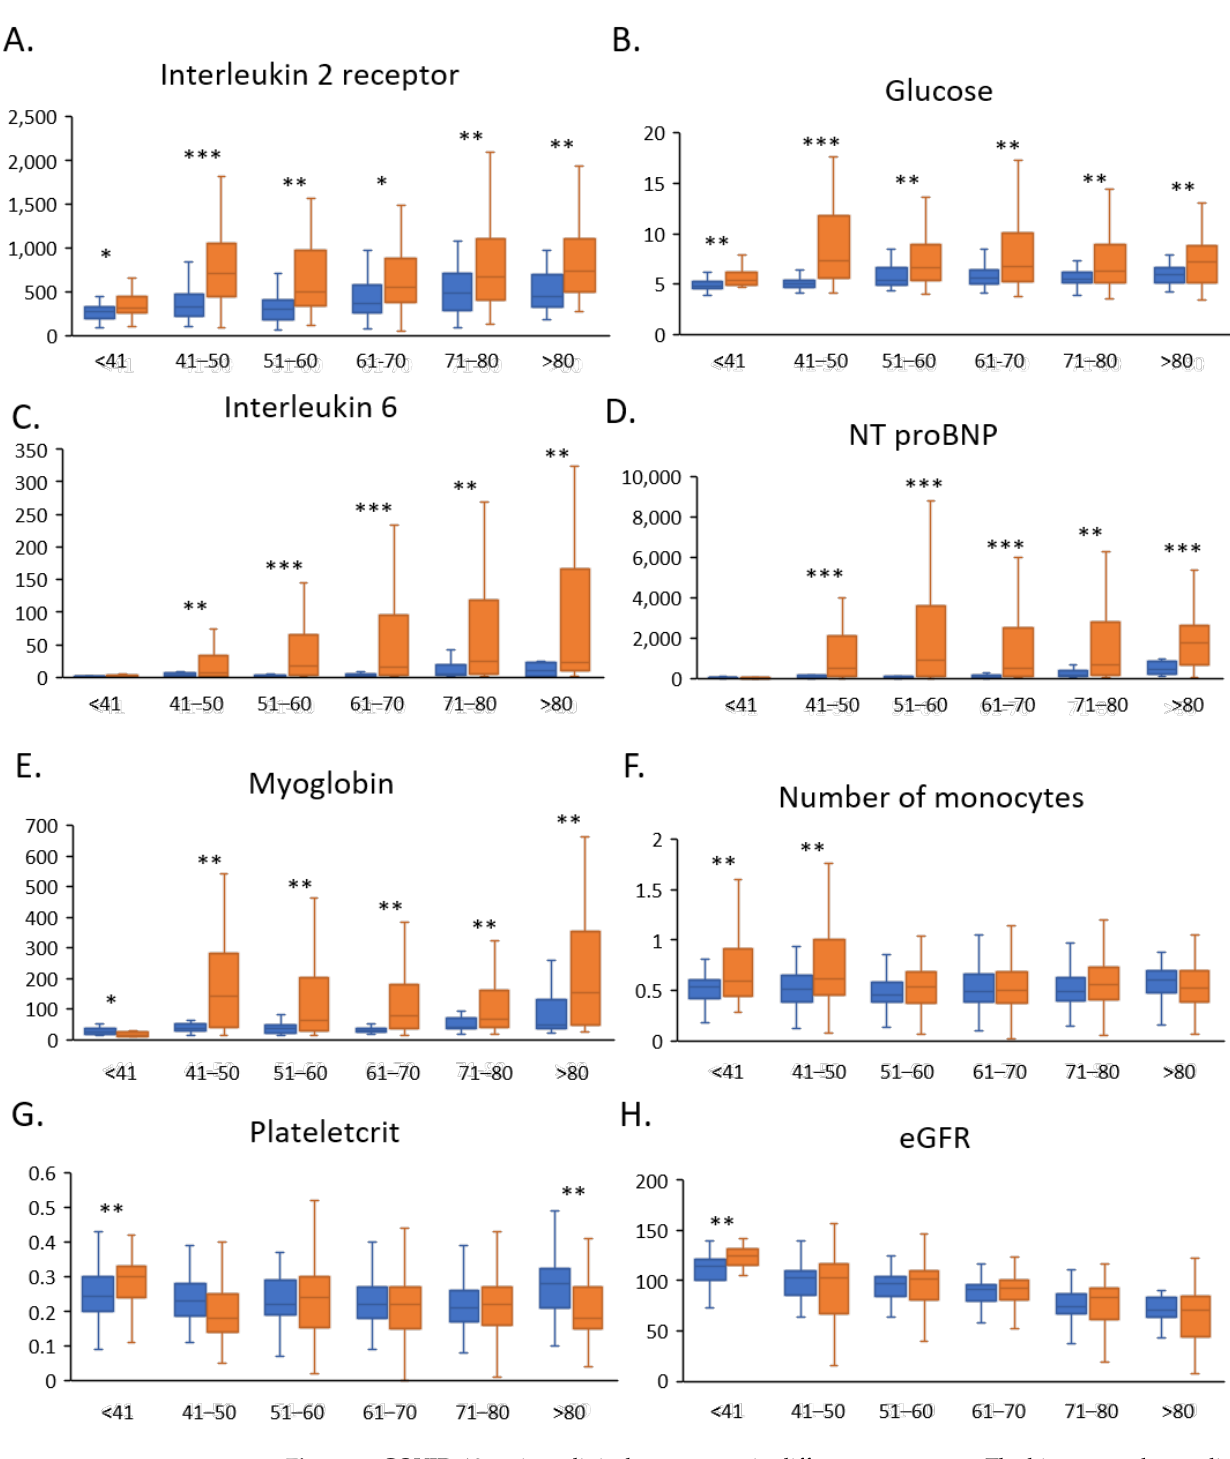
Figure 2. COVID-19 patient clinical parameters in different age groups. The histogram shows clinical parameters in COVID-19 patients with mild to severe disease in different age groups, i.e., ( A ) Interleukin 2 receptor, ( B ) Glucose, ( C ) Interleukin 6, ( D ) NT proBNP (N-terminal pro brain natriuretic peptide), ( E ) Myoglobin, ( F ) Number of monocytes, ( G ) Plateletcrit, ( H ) eGFR. Blue histograms represent mild patients and orange histograms represent severe patients. Blue = mild patients; Yellow = severe patients. * p < 0.05, ** p < 0.01, or *** p < 0.01 were considered statistically significant.